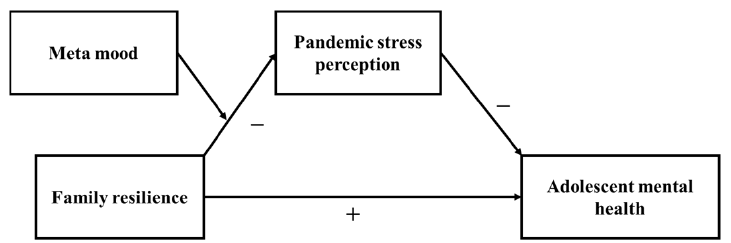
Figure 1. Conceptual model.